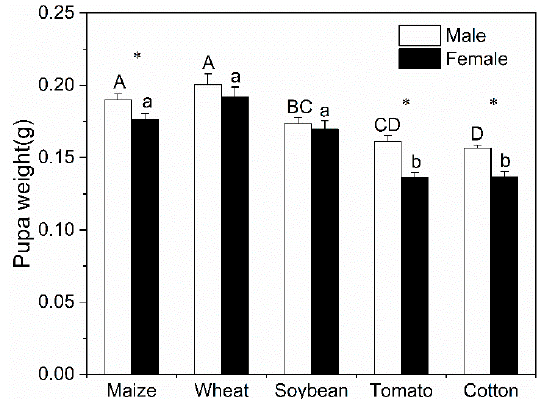
Figure 1. Pupa weight of S. frugiperda fed on five plant species. Different uppercase and lowercase letters indicate significant differences among different plant species ( p < 0.05), respectively. *